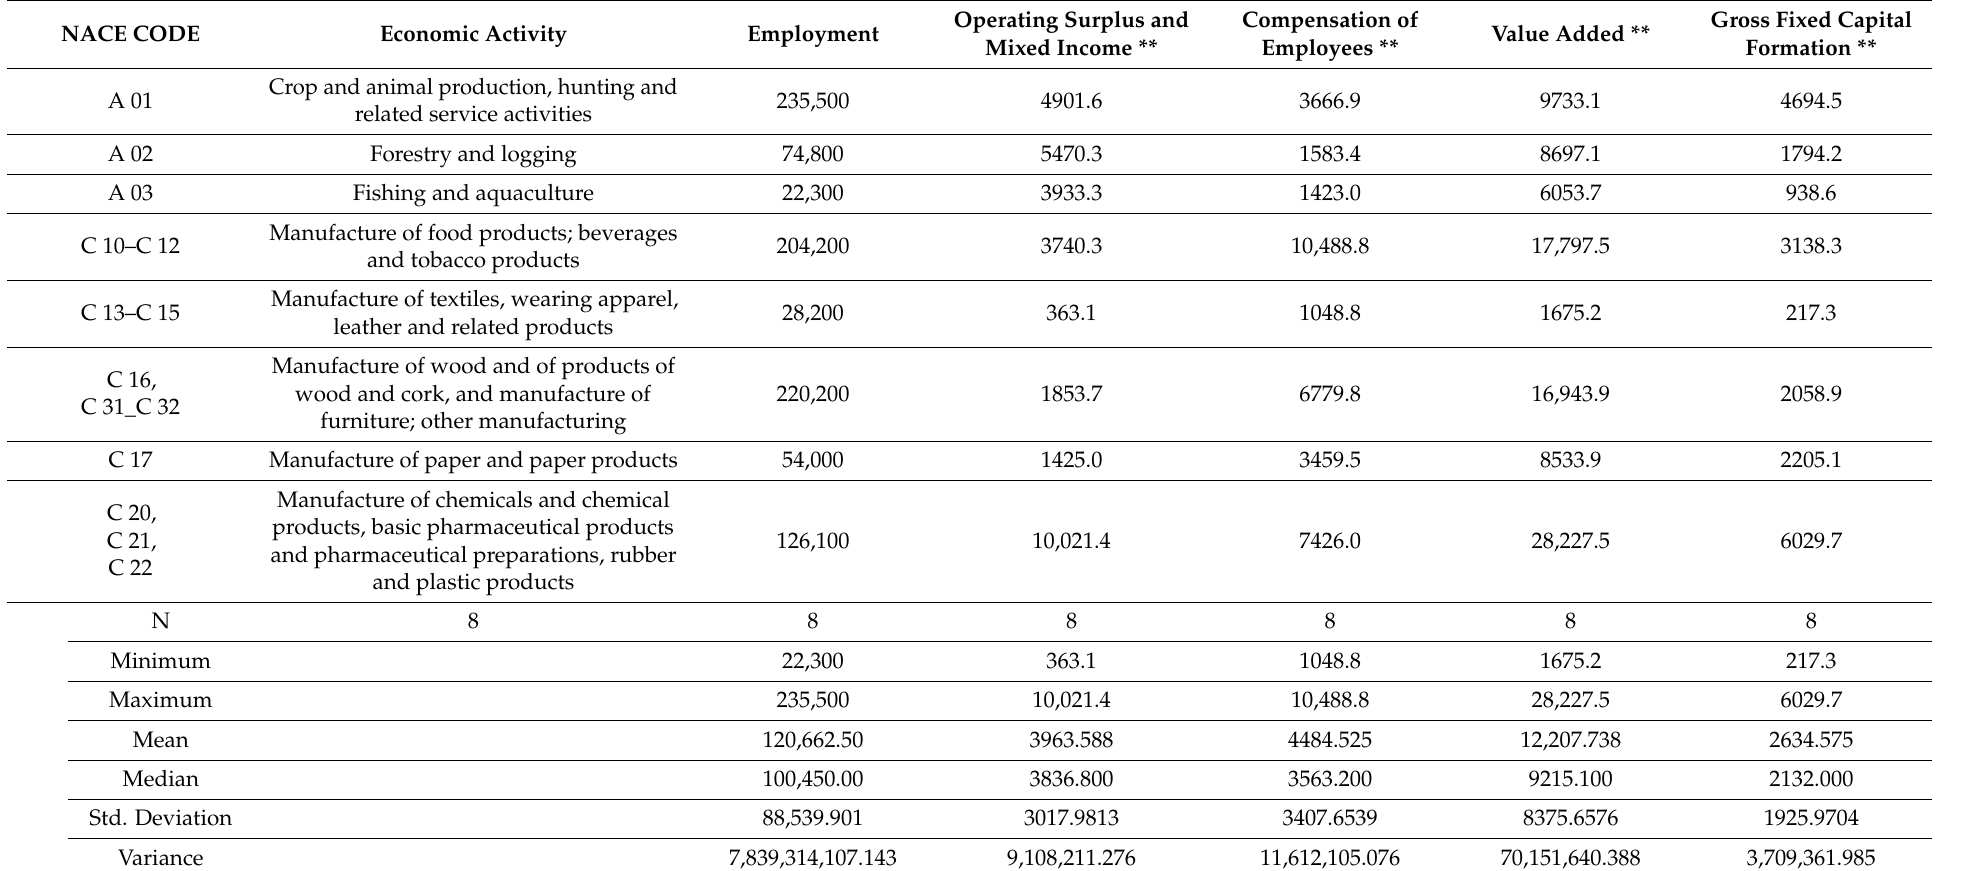
Table A1. Data Overview * of Economic Performance among Nordic Bioeconomy Sectors